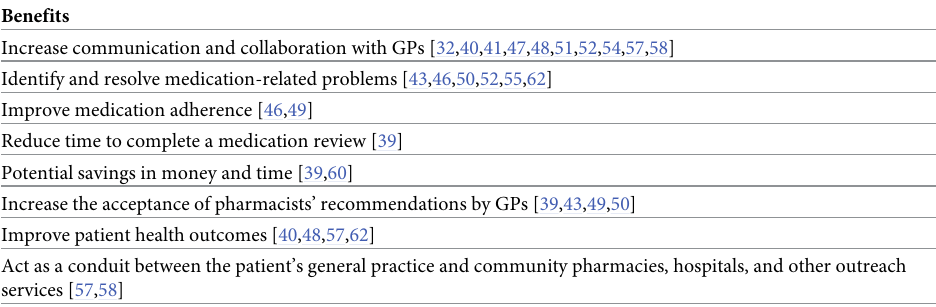
Table 1. Benefits of the inclusion of general practice pharmacists. Benefits Increase communication and collaboration with GPs [32,40,41,47,48,51,52,54,57,58] Identify and resolve medication-related problems [43,46,50,52,55,62] Improve medication adherence